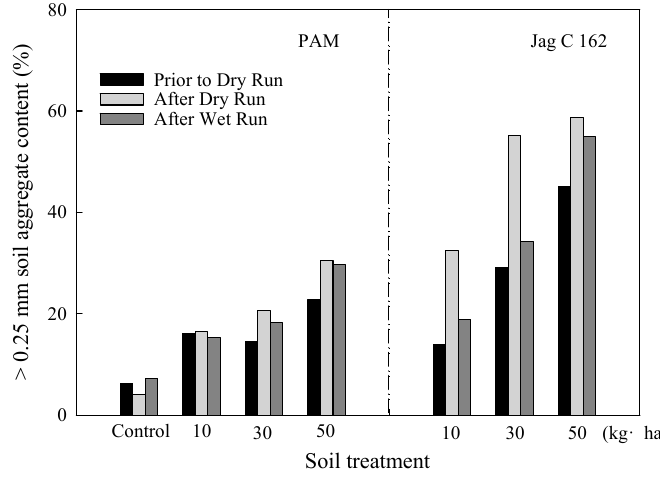
PAM and Jag C 162. Subscripts indicate the standard deviation of the six samplings.